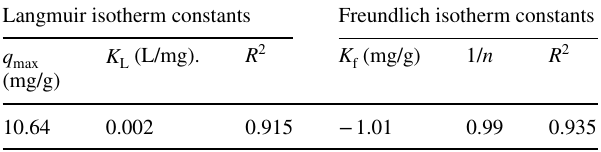
Table 4 Adsorption isotherm constants and coefficient of determina- tion Langmuir isotherm constants Freundlich isotherm